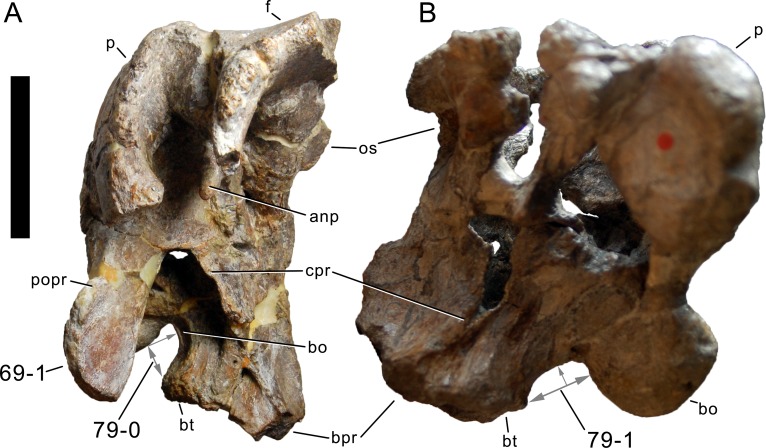
Flagellicaudatan braincases.Braincase of Suuwassea emilieae ANS 21122 (A) and Tornieria africana MB.R.2386 (B) in right (A) and left (B) lateral view, illustrating the curved lateral end of the paroccipital process (A; C69-1), and the short (A; C79-0) and elongate basioccipital (B; C79-1). Abb.: anp, antotic process; bo, basioccipital; bpr, basipterygoid process; bt, basal tuber; cpr, crista prootica; f, frontal; os, orbitosphenoid; p, parietal; popr, paroccipital process. Scale bar = 5 cm.